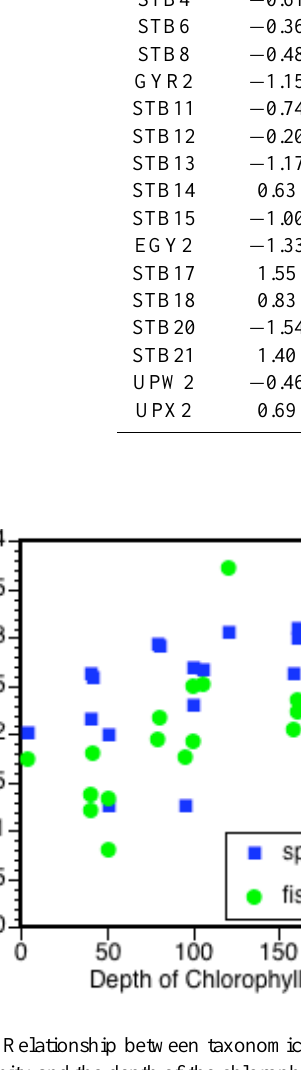
Fig. 4. Relationship between taxonomic diversity of the tintinnid Fig. 4 Relationship between taxonomic diversity of the tintinnid community and the depth of community and the depth of the chlorophyll maximum the chlorophyll maximum layer.